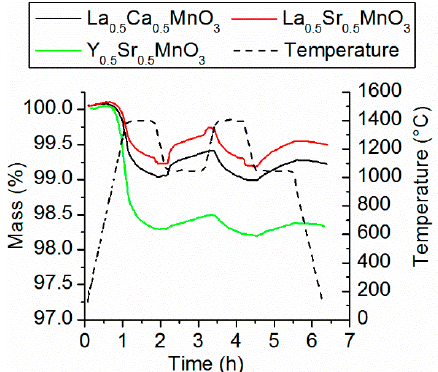
Figure 9. TGA of La 0.5 Sr 0.5 MnO 3 , La 0.5 Ca 0.5 MnO 3 , and Y 0.5 Sr 0.5 MnO 3 during two thermochemical cycles (T red = 1400 °C and T ox = 1050 °C)